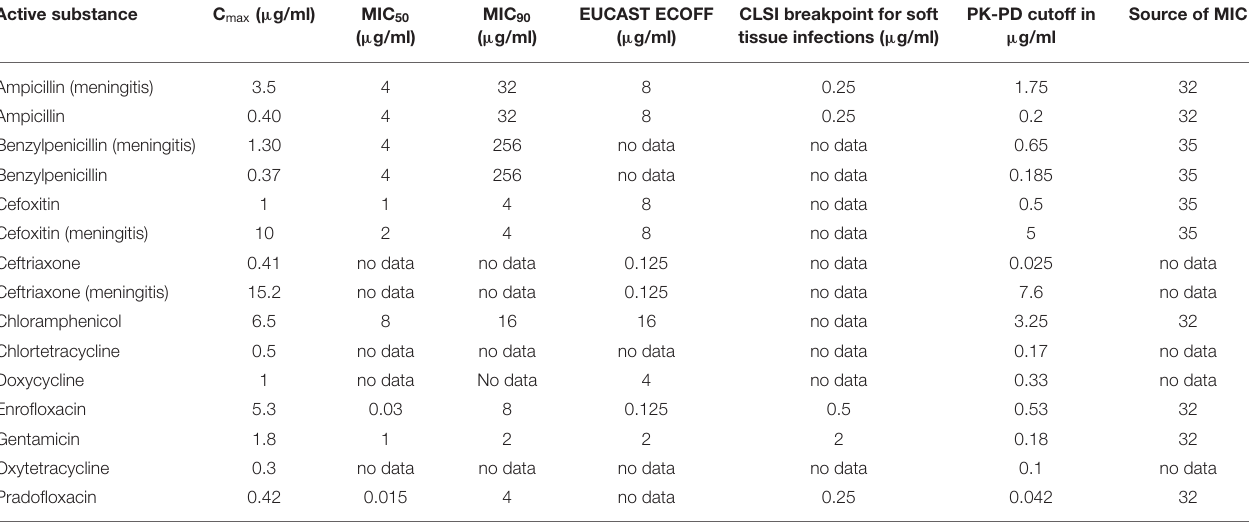
TABLE 10 | C max in CSF in dogs after the administration of various antibiotics in healthy dogs or during meningitis (ampicillin, benzylpenicillin) and selected PK-PD cutoffs of E. coli . Active substance